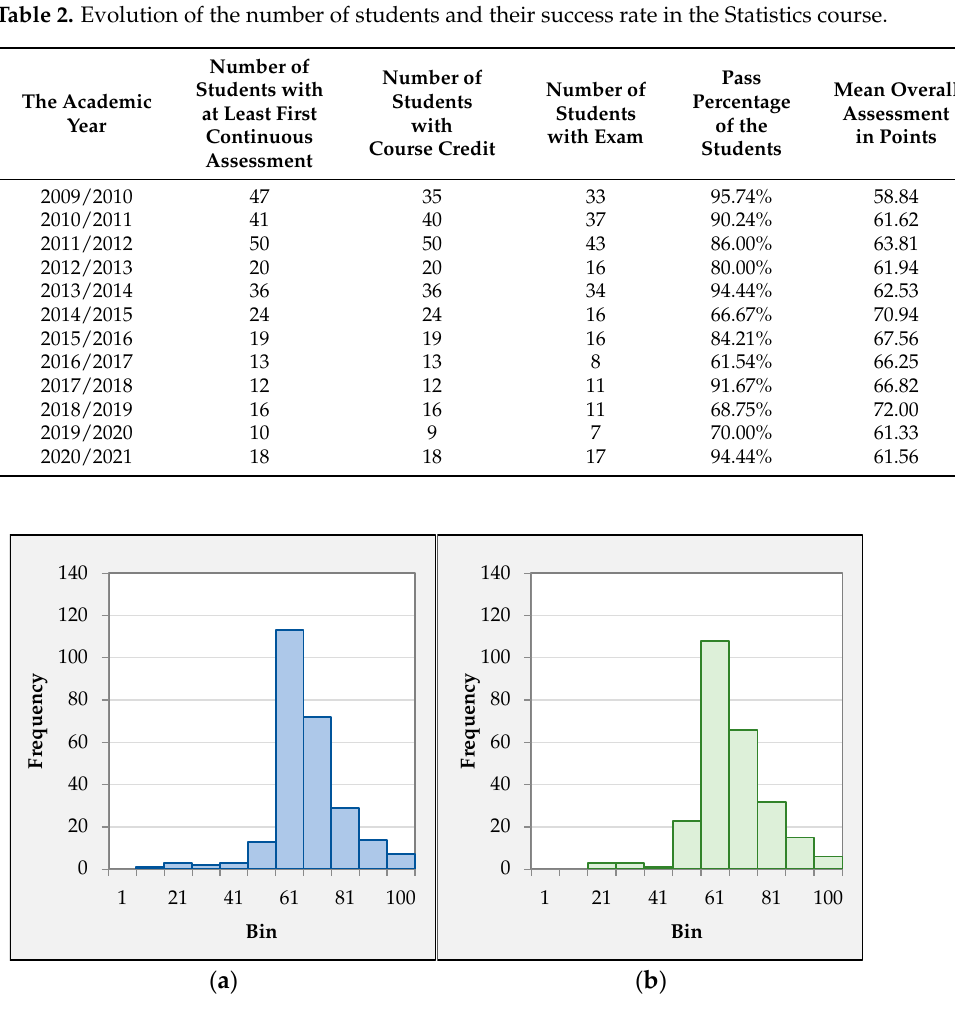
Figure 7. The box plots of the overall assessments of the Mathematics course and the Statistics course. The relationship between the overall assessments in the Mathematics course and the Statistics course is shown in Figure 8. The graph shows the overall assessments of all stu- dents who successfully completed both courses and the students did not always complete the courses in the same academic year (Table 3). The dependence of the overall assess- ments ( OA ) expresses a first-degree polynomial of the form 5.59 0.92 OA of Statistics course